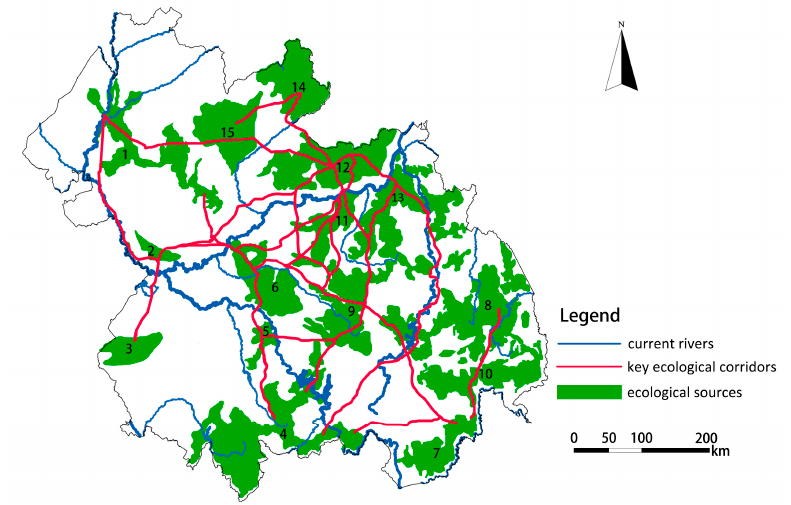
Figure 6. The spatial distribution of key ecological corridors.